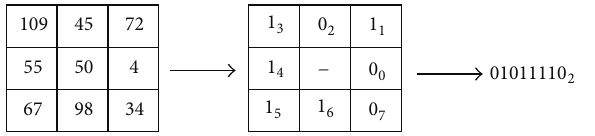
Figure 5: LBP calculation example.